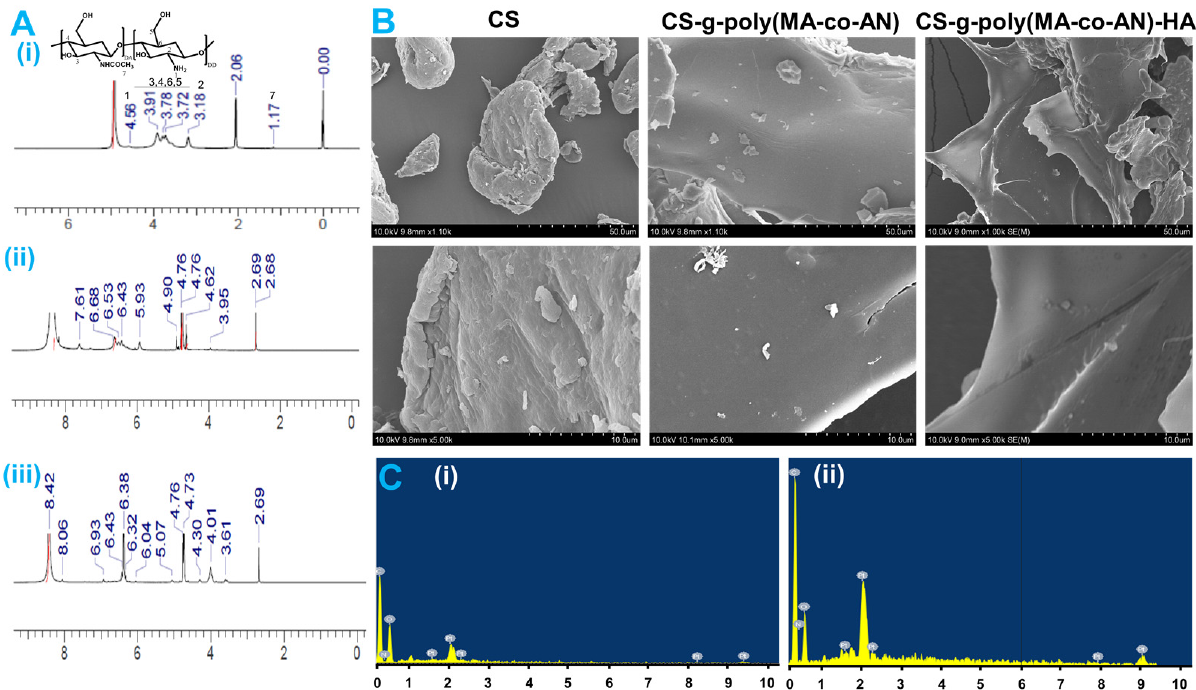
Figure 2. Representing the NMR analysis and surface characterization; ( A ) 1 H NMR spectra of the ( i ) CS, ( ii ) CS-g-poly (MA-co-AN), and ( iii ) CS-g-poly (MA-co-AN) HA; ( B ) Surface characterization by SEM, ( C ) EDX mapping of ( i ) CS-g-poly (MA-co-AN), and ( ii ) CS-g-poly (MA-co-AN)